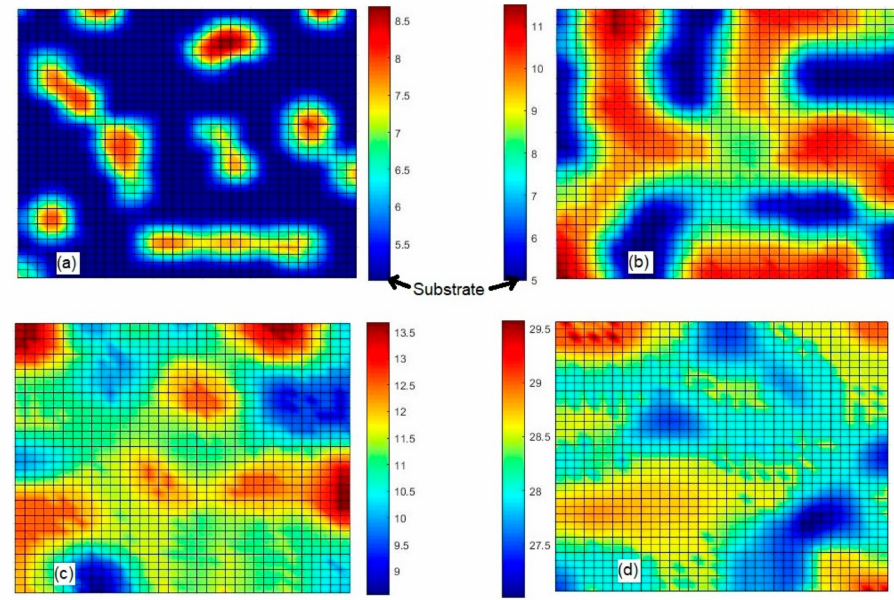
Figure 7. Surface maps of the thin film grown at the temperature 773 K with the relative flux i = 1 s − 1 taken at t = 0.625 s ( a ), t = 3.25 s ( b ), t = 6.375 s ( c ), and t = 25 s ( d